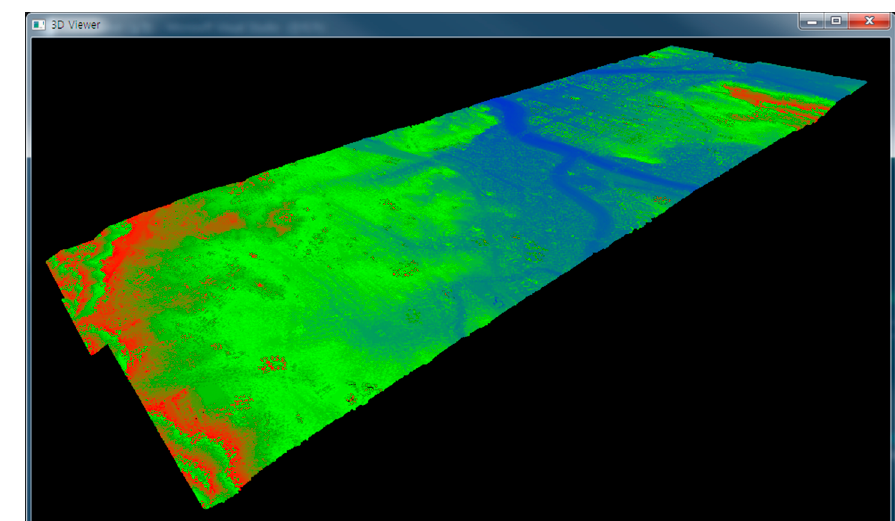
Figure 11. 3D point cloud of an urban area. Table 1. Specifications of data.